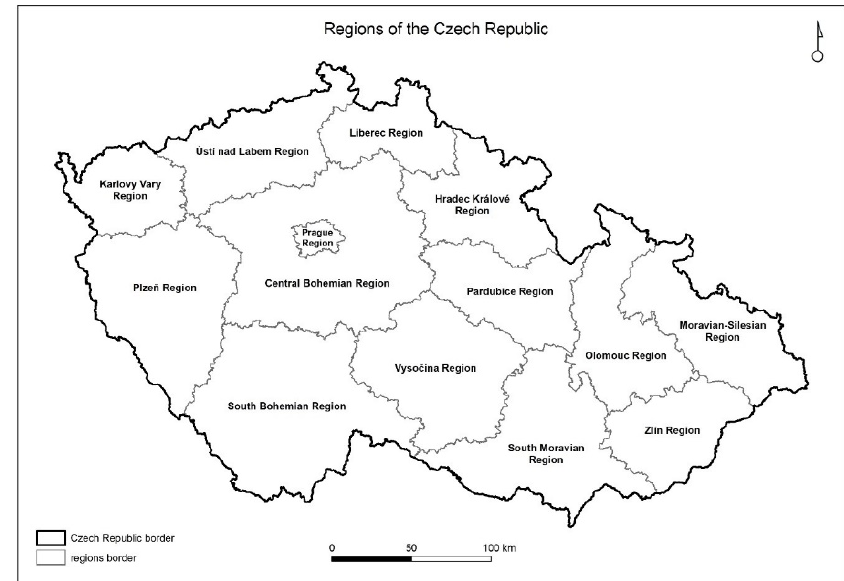
Figure 3. Regions of the Czech Republic.